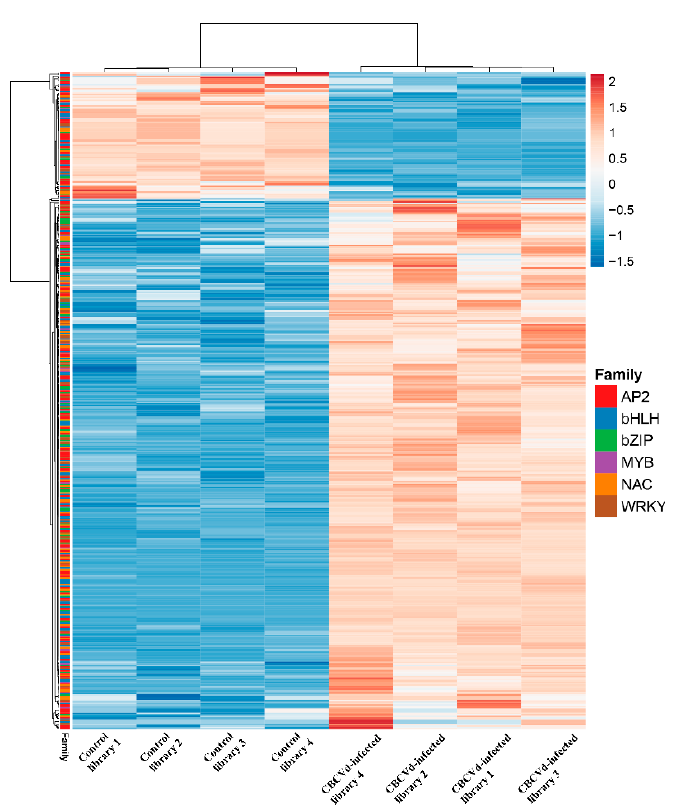
Figure 3. RNA-seq transcript abundance of Citrus bark cracking viroid (CBCVd) infected and control (healthy) hop plants. The values are expressed as the log2 value of average fragments per kilobase of exon per million fragments mapped (FPKM) per sample. The heatmap with clustering was drawn using the online Clustvis tool.